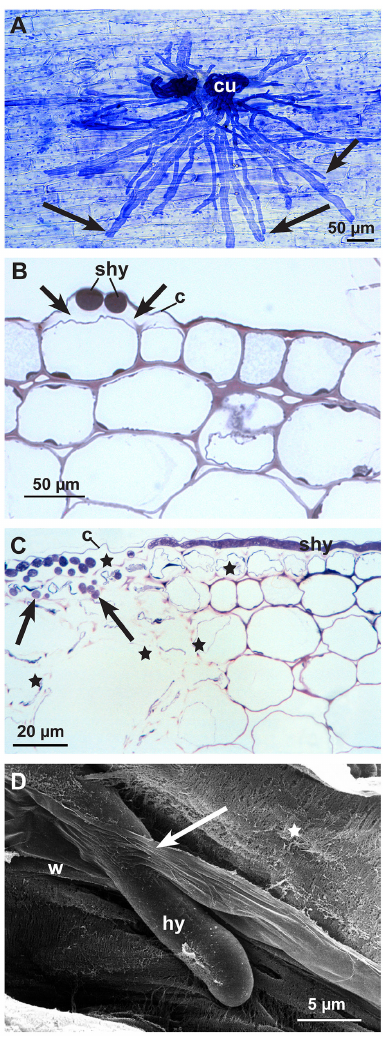
Figure 3. Infection process of the early (12-24 hpi) and advanced infection stages (36-48 hpi). Subcuticular hyphae and hyphal growth starting in epidermal and adjacent cortical parenchyma cells. A : Subcuticular hyphae (arrows) spreading fan-like from two infection cushions (cu). Light micrograph of an epidermal strip stained with Coomassie blue 12-24 hpi. B : Cross section of subcuticular hyphae (shy) near hyphal tips in the abaxial cell wall. Under the cuticle (c) around hyphae the loss of contrast and the widening of the cell wall indicating cell wall degradation (arrows). Light micrograph stained with toluidine blue 12-24 hpi. C : Cross section of infected hypocotyl with subcuticular hyphae (shy) under the cuticle (c) and hyphae growing deeper into the host tissue (arrows). Cell walls and cytoplasm of the epidermal cells are completely destroyed as well as parts of the cortical parenchyma (stars). Light micrograph stained with toluidine blue 36-48 hpi. D : Scanning electron micrograph, 36-48 hpi. In a cortical parenchyma cell the fibrillar (stars) and lamellar (arrow) structure of the degrading cell wall (w) becomes visible around an invading hyphae (hy) by conventional SEM.